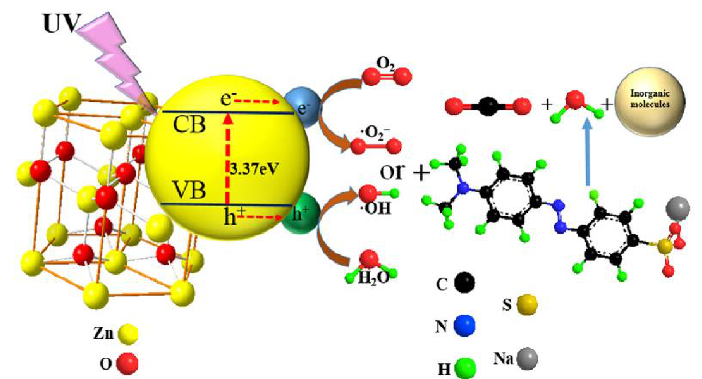
Figure 1. General mechanism for photocatalytic degradation of azo dyes under UV illumination on ZnO catalyst. Reproduced from [13] with permission from Springer.